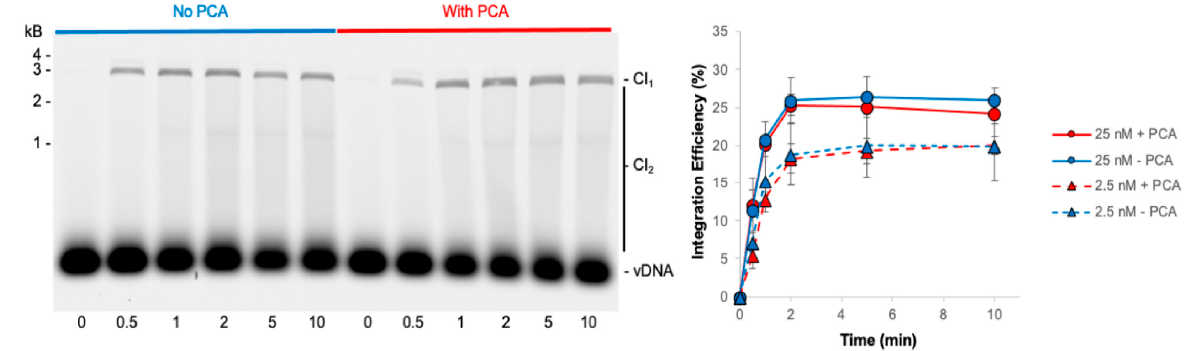
Figure 5. PCA does not alter the kinetics of PFV intasome integration. PFV integration over time was assayed in the absence or presence of 5 mM PCA. As PCA has been shown to reduce aggregation of PFV intasomes, two concentrations of intasomes were assayed: 25 and 2.5 nM. Cy5 image of agarose gel with 25 nM PFV intasomes shows the accumulation of CI 1 and CI 2 products over time. The total Cy5 fluorescence in each lane was quantified and each integration product calculated as the fraction of the total fluorescence. PCA did not affect the kinetics of integration at either concentration. The average of three independent experiments with at least two independent intasomes preparations is shown. Error bars indicate the standard deviation.